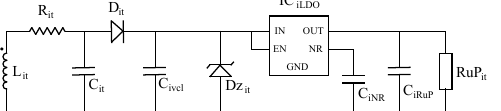
Figure 9. Batteryless sensor node equivalent